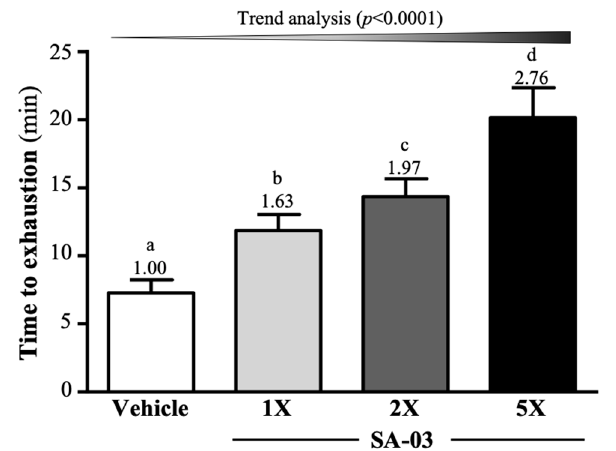
Figure 2. Effect of four weeks of SA-03 supplementation on exhaustive swim time. Data are expressed as mean ± SD ( n = 10 mice per group). Different superscript letters (a, b, c, d) indicate significant difference ( p < 0.05).